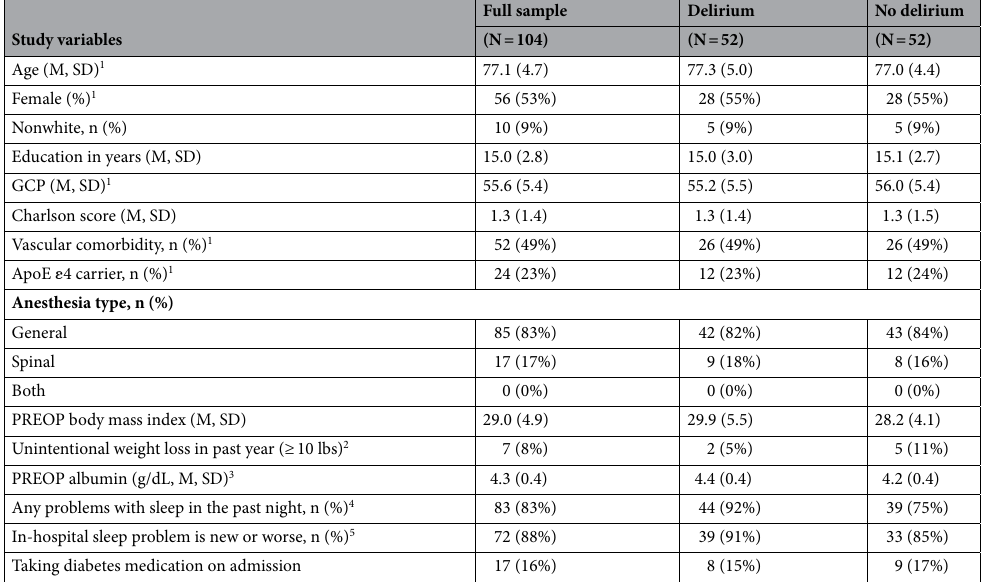
Table 1. Sample characteristics in the matched cohorts. 1 Variable used for matching. 2 Full sample N = 85 (delirium n = 39, no delirium n = 46). 3 Full sample N = 34 (delirium n = 15, no delirium n = 19); albumin was tested only when malnutrition was suspected. 4 Positive response to question on either POD1 or POD2; Sample for this question: N = 100 (delirium n = 48, no delirium n = 52). 5 Sample for this question: N = 82 (delirium n = 43, No delirium n = 39). Abbreviations : ApoE = Apolipoprotein E, GCP = general cognitive performance, M = mean, 3MS = Modified Mini-Mental State Examination, SD = standard deviation, PREOP = preoperative, POD = postoperative